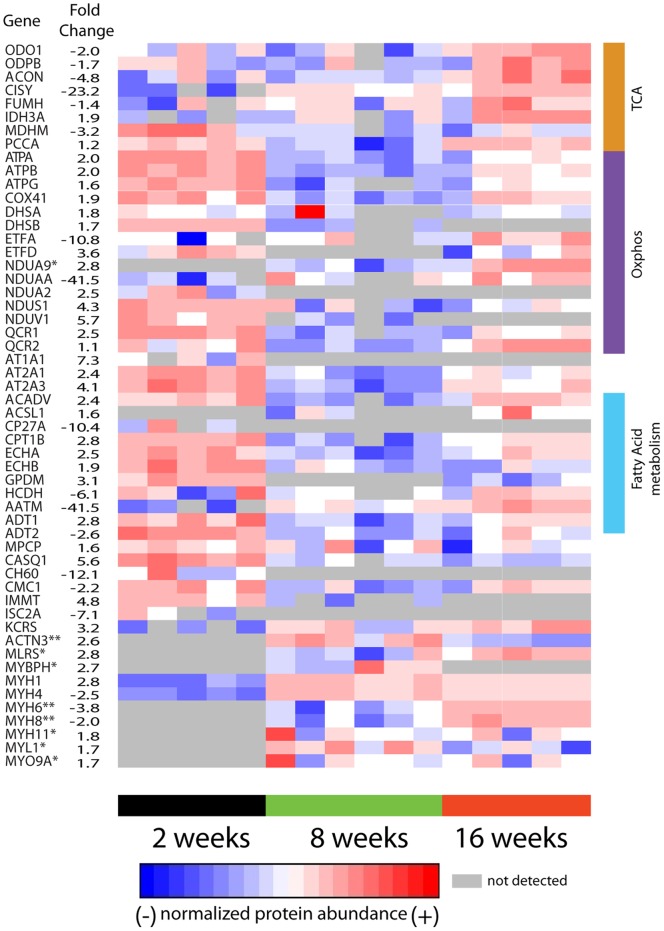
Diet induced alterations in protein abundance.Shown are proteins (rows) found to significantly differ in abundance (p<0.05) comparing mice (columns) on HFD and SD for 2-, 8-, or 16-weeks. The average fold change between mice on SD and HFD is reported for the 2 week time interval unless otherwise indicated, * indicates fold change at 8 weeks, and ** indicates fold change at 16-weeks. A single outlier at 2- and 16-week time points was removed from the HFD group.